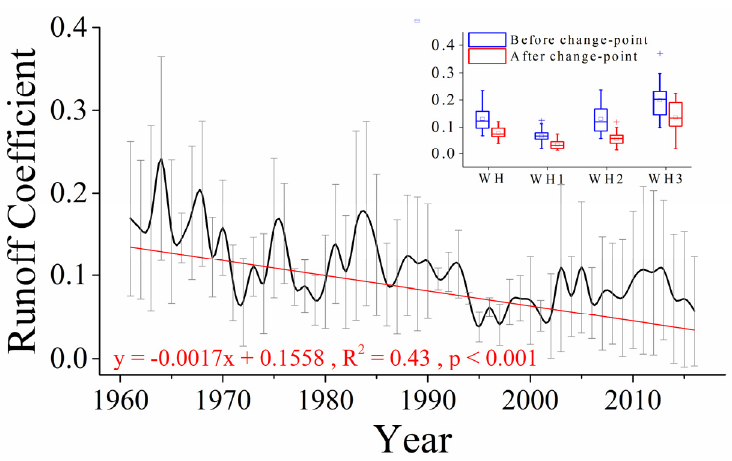
Figure 9. The time series of the runo ff coefficient (runo ff /precipitation) of Weihe River. Water yield (WY) is an important indicator to represent the ecosystem service of water provision.